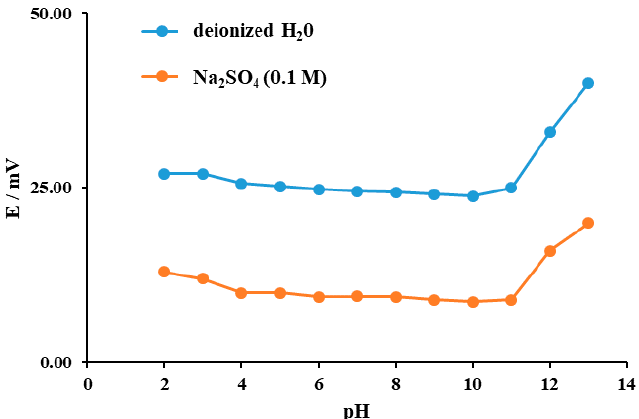
Figure 2. The study of the pH influence on the DHBI–TPB surfactant sensor response towards (1) hexadecyltrimethylammonium bromide (CTAB) (0.5 mM) in deionized water and (2) CTAB (0.5 mM) in Na 2 SO 4 (0.1 mM).